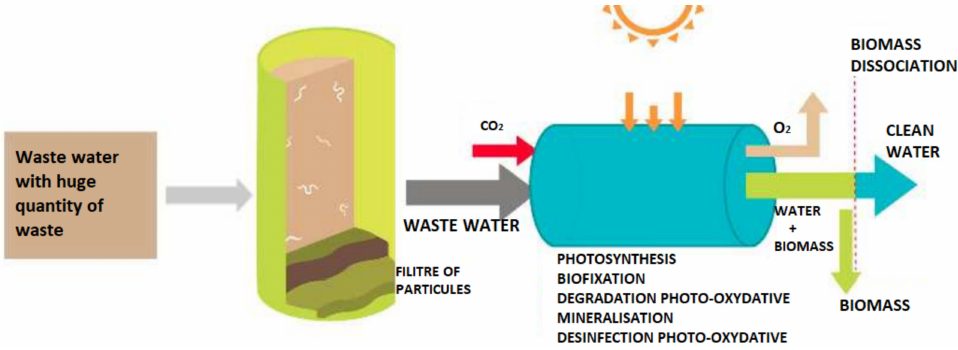
Figure 13. Greywater filtration of BAITYKOOL house. Adapted from ref.